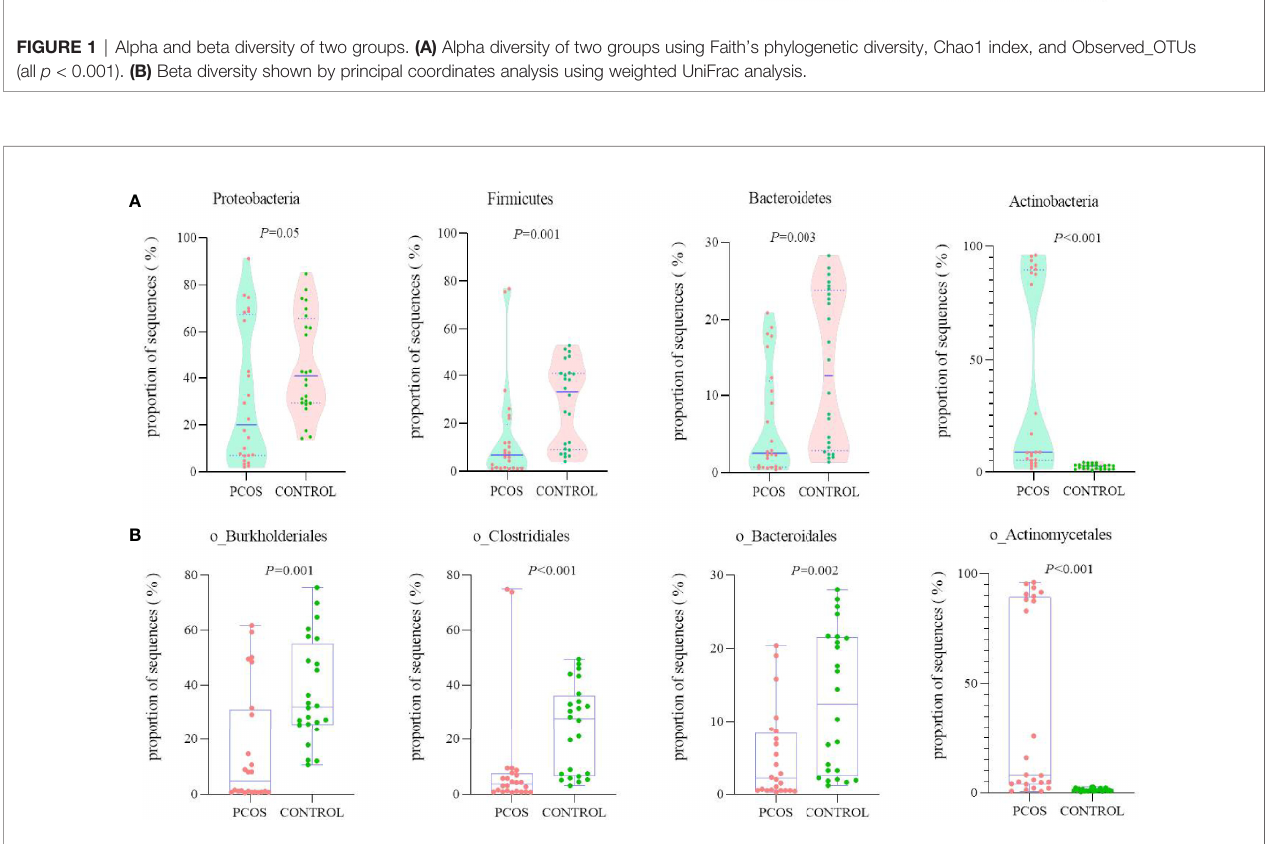
FIGURE 2 | Comparison of the relative abundance of the top 4 richest bacteria between PCOS and control groups at two levels. (A) Phylum; (B) order.